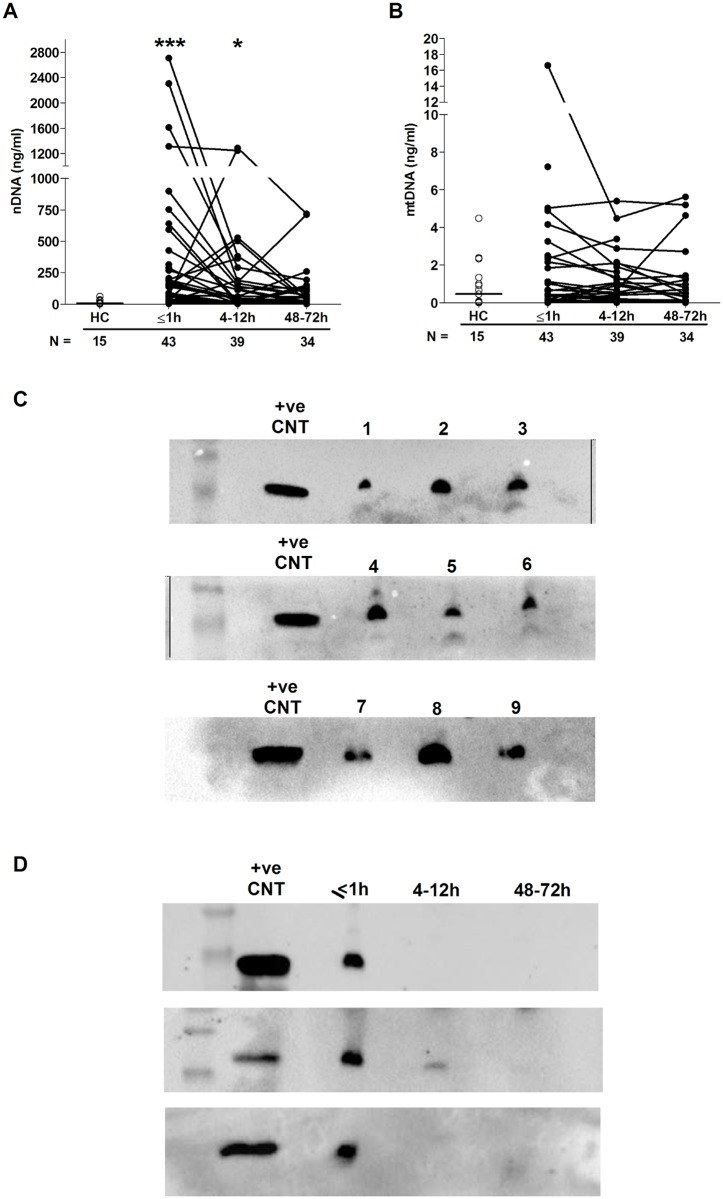
Evidence of NET formation during the ultra-early immune response to sterile traumatic injury.(A–B) Plasma concentrations (ng/ml) of nuclear (A) and mitochondrial (B) DNA across time post-trauma. The number of samples analysed is indicated below each time point. The horizontal line for HC data depicts the median value. *p < 0.05, ***p < 0.0005 versus HCs. (C–D) Western blots showing the levels of citrullinated histone H3 in plasma samples obtained from 9 trauma patients within 1 hour of injury (C) and in 3 trauma patients across the 3 postinjury time points (D). +ve CNT, positive control; HC, healthy control; mtDNA, mitochondrial DNA; nDNA, nuclear DNA; NET, neutrophil extracellular trap.